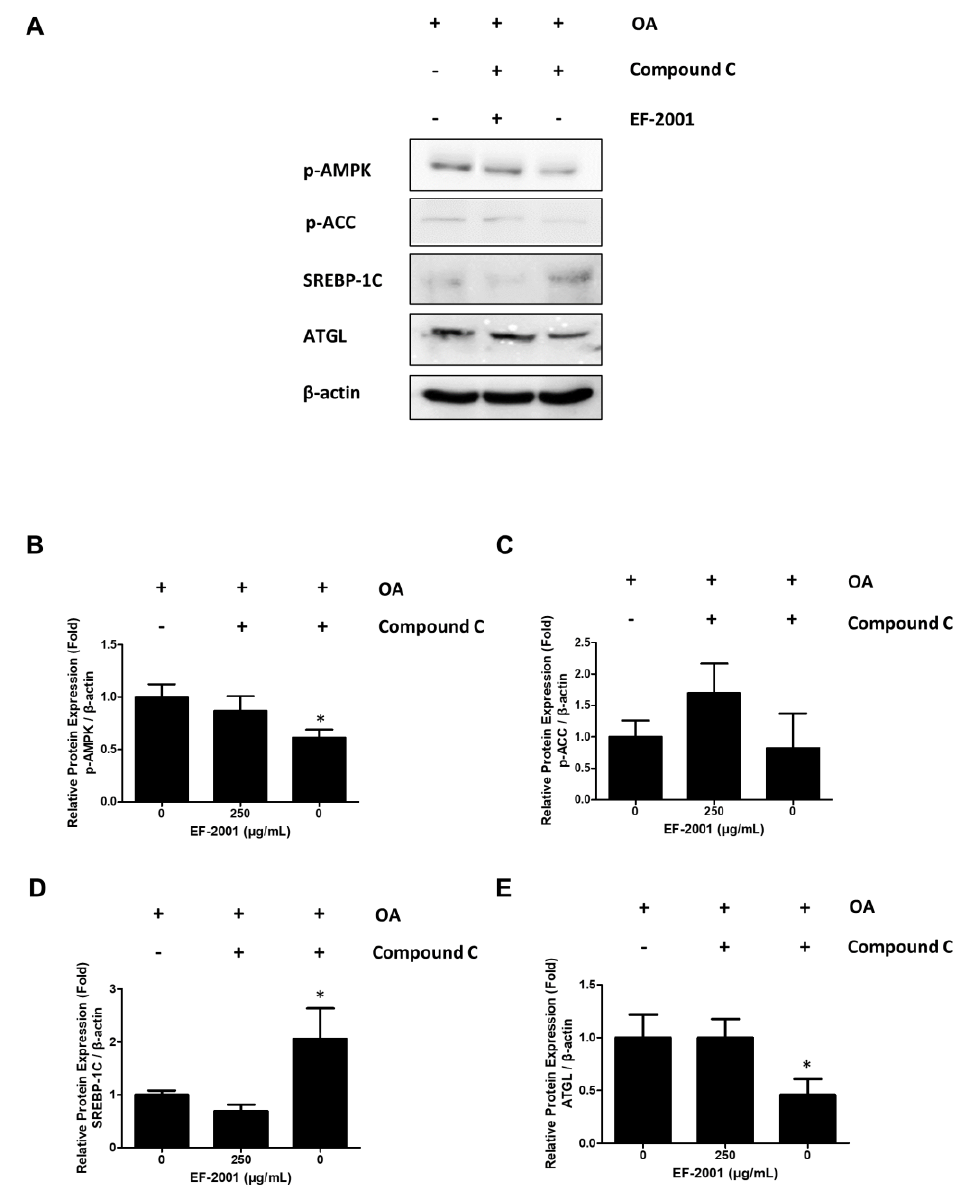
Figure 7. Effects of EF-2001 on AMPK signaling pathways with AICAR and compound C in FL83B hepatocytes. The AMPK signaling pathway proteins were detected by western blotting analysis. ( A ) FL83Bs were treated with 0.5 mM oleic acid (OA) for 48 h, followed by EF-2001 (250 µ g/mL) with or without AMPK inhibitor (compound C) for 24 h. The relative protein expression levels of p-AMPK (B ), p-ACC ( C ), SREBP-1C ( D ), and ATGL ( E ) are shown in the graphs. The fold expression levels were measured relative to the expression of β -actin. Three independent experiments were analyzed, and the fold expression levels were measured relative to the expression of β -actin. Data are presented as mean ± SEM; * p < 0.05 compared with the OA group.